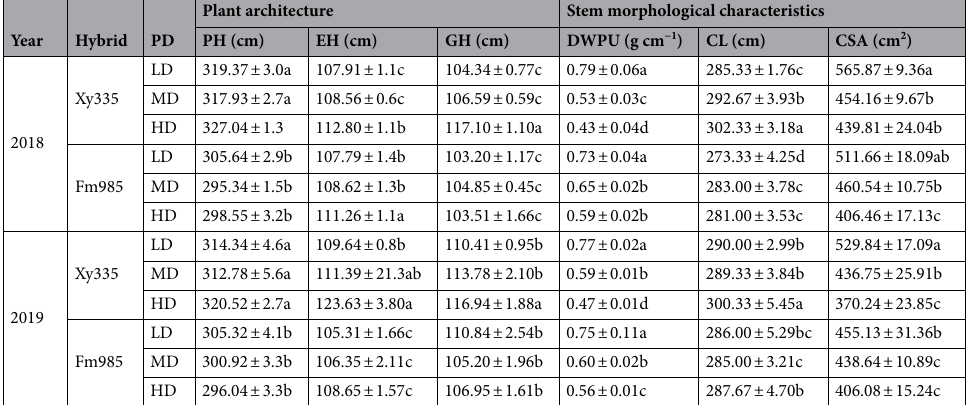
Table 3. Plant architecture and stem morphological characteristics under different treatments. PD, planting density; PH, plant height; EH, ear height; GH, gravity height; DWPU, dry weight per unit length; CL, culm length; CAS, stem cross-section area. Mean ± SE (n = 3). Different lowercase letters in the same column indicate a statistically significant difference at 0.05